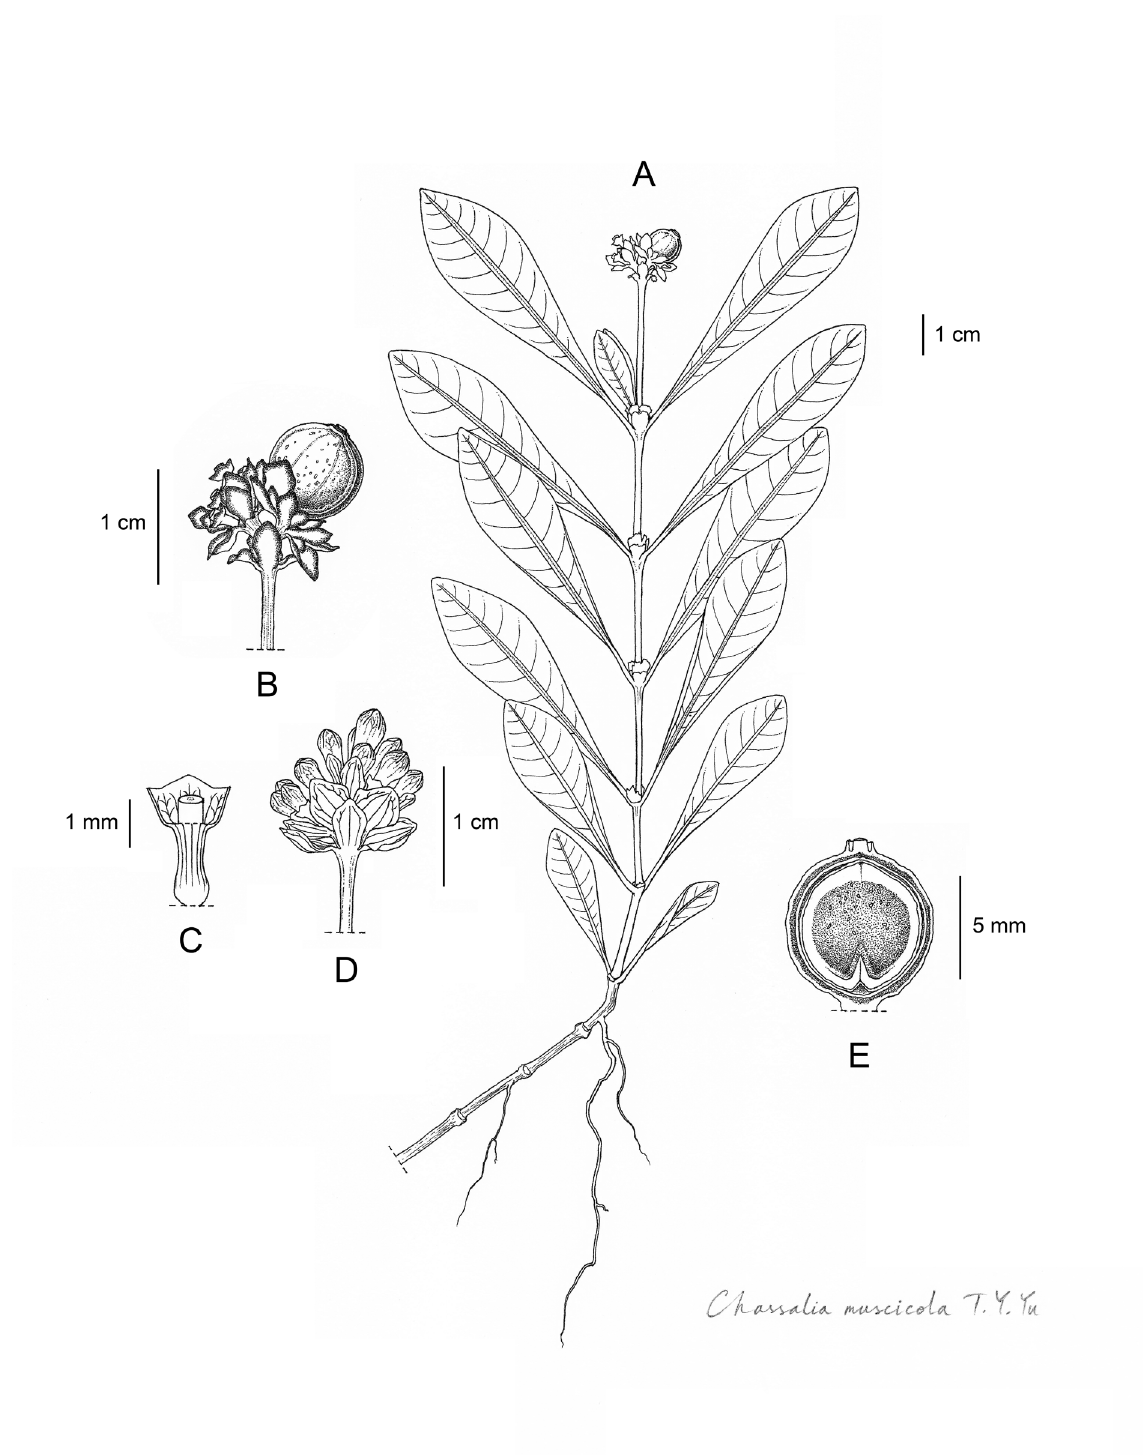
Fig. 26. Chassalia muscicola T.Y.Yu sp. nov. A . Habit. B . Infructescence. C . Hypanthium, calyx and disc of a flower. D . Inflorescence. E . Pyrene ventral surface. A–B, E from Ilias & Azahari S 35671 ; C–D from S. Collenette 742 . Drawn by T.Y.